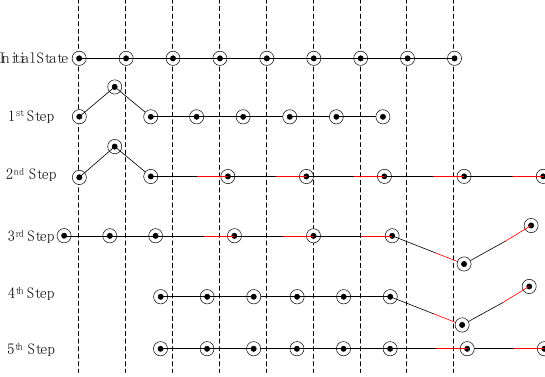
Figure 5. Obstacle-aided locomotion model.